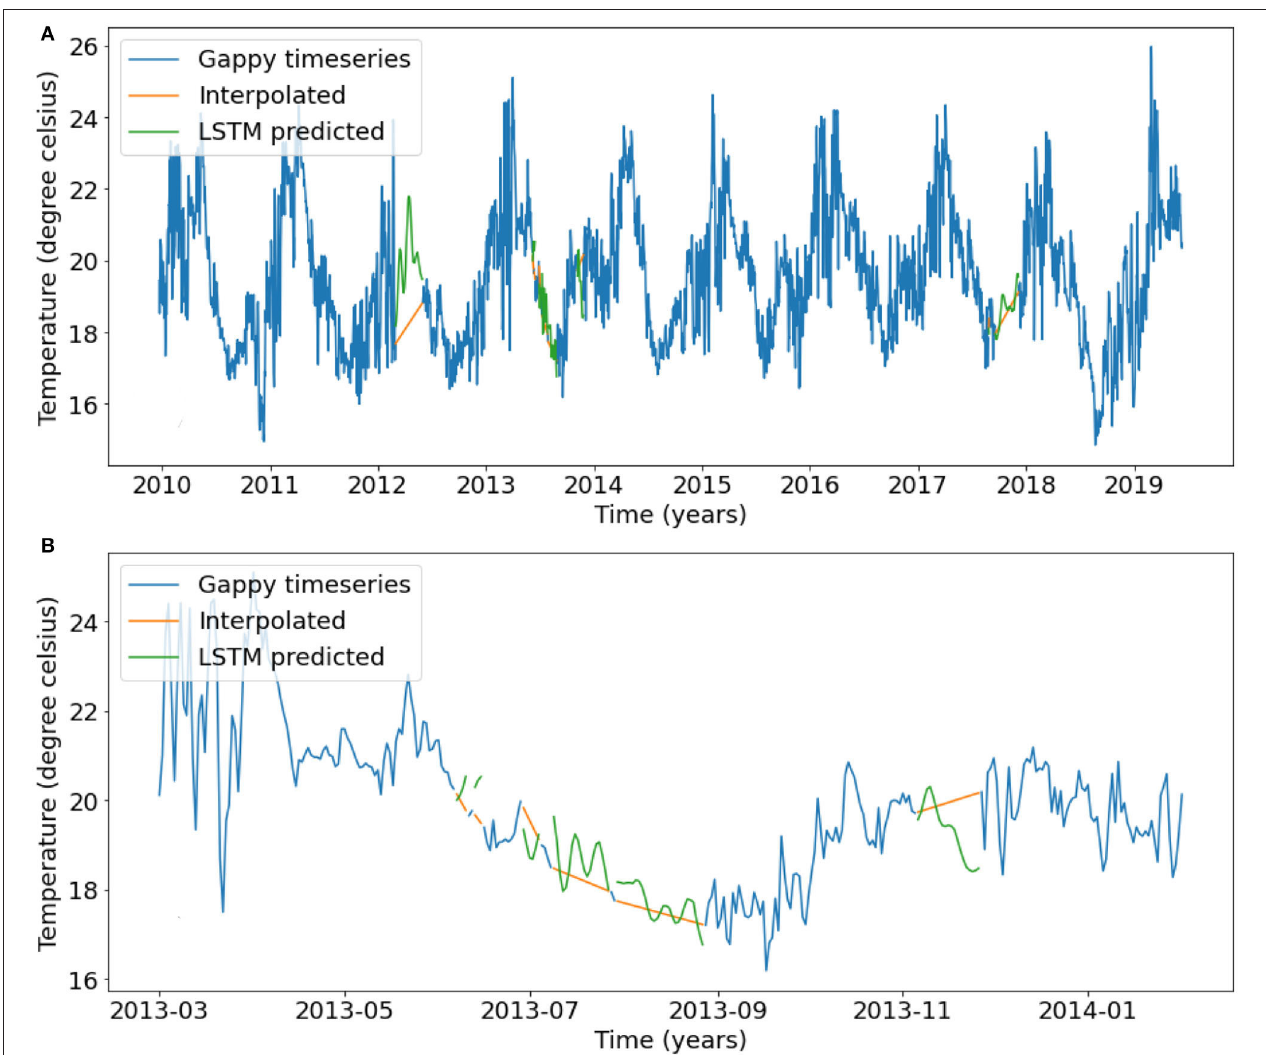
FIGURE 12 | (A) The final filled temperature timeseries at the 24.5m bin of the Port Hacking mooring. Blue line represents the original timeseries with gaps, green lines represent the predictions from the LSTM models and the orange lines represent the predictions from linear interpolation. The long 2012 and 2017 gaps were filled using the 91-day model 3, the gaps longer than 6 days were filled using the 30 day model 2, and the remaining gaps were filled using model 1. (B) Same as (A) but zoomed in on the series of gaps in